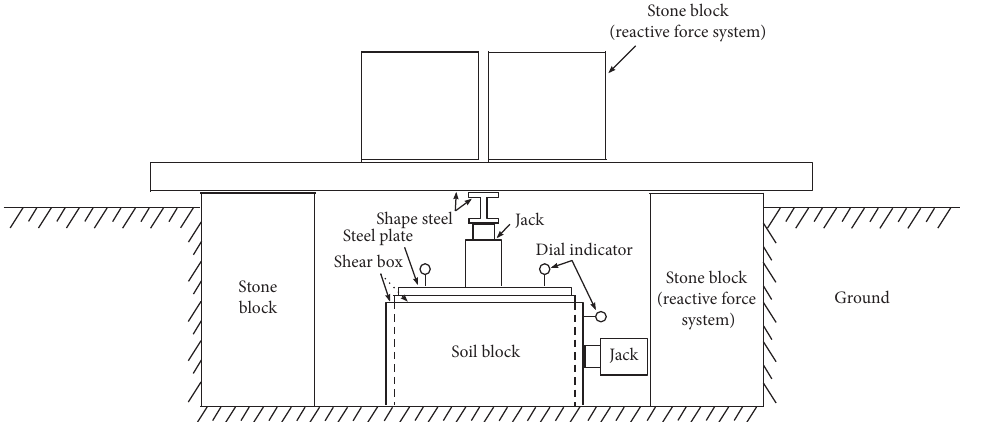
Figure 3: Illustration of the in situ direct shear